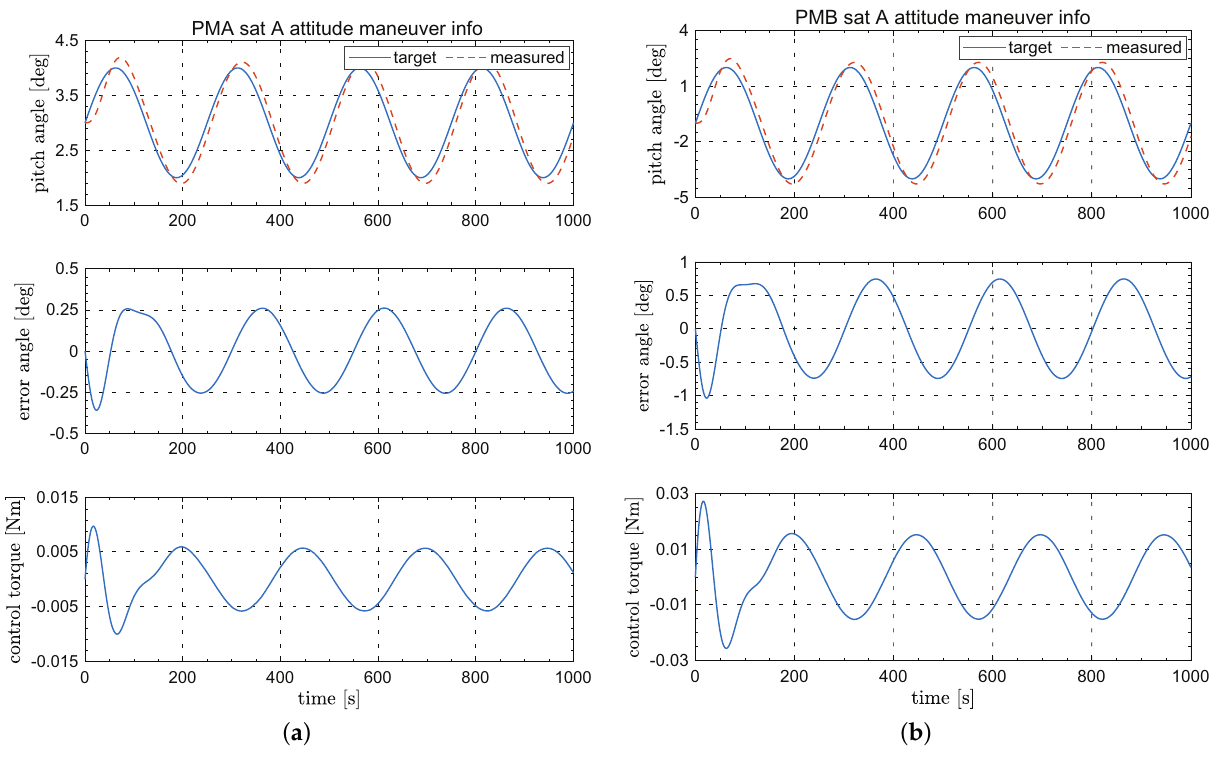
Figure 6. Software simulation of APC calibration maneuver (MA & MB). ( a ) Satellite A yaw maneuver information. ( b ) Satellite A pitch maneuver information